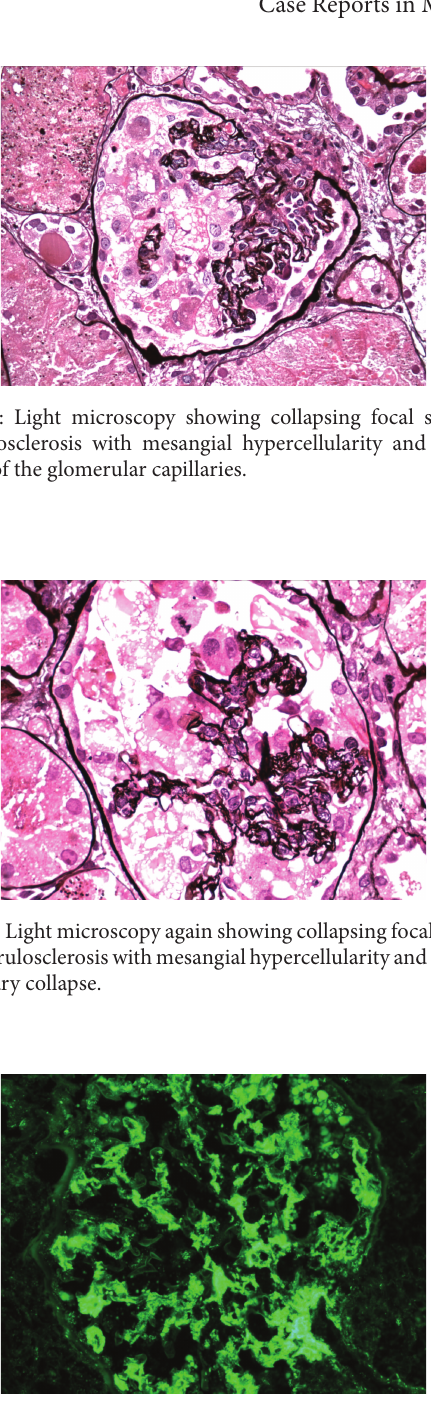
Figure 3: Immunofluorescence reveals granular global mesangial